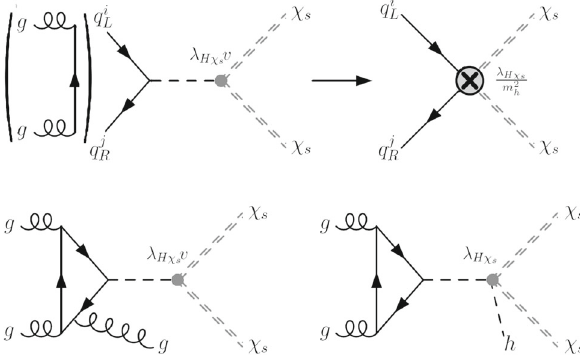
Fig. 15 Relevant diagrams contributing to nuclear interaction with scalar DM (first row) and corresponding DM observables at hadron colliders (monojet and Higgs + / E T , second row), turning on the inter- action ∼ λ H χ